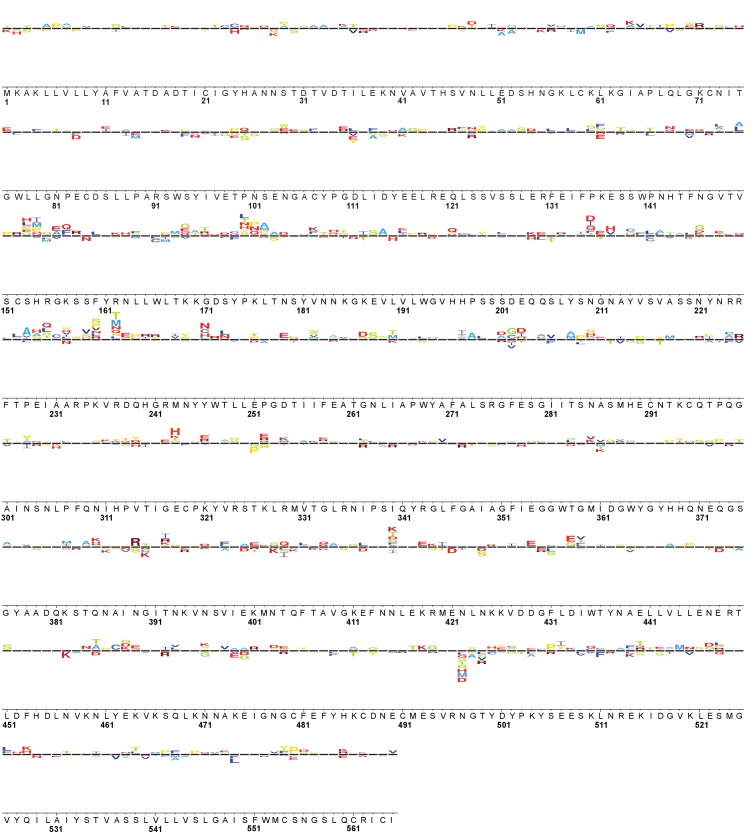
Full WSN HA sequence logo plot: ATF6f/XBP1s 37˚C vs. Basal 37˚C.Logo plot displays variants that behaved consistently across three biological replicates. Variants above the line (representative of selection on wild-type) were enriched upon ATF6f/XBP1s induction at 37˚C; variants below the line were depleted. The wild-type WSN HA residue is shown below the corresponding logo, with the sites numbered below the wild-type sequence (based on sequential numbering of WSN HA). The size of the amino acid letter abbreviation is proportional to the diffsel for that amino acid variant, and all logo plots are plotted on the same scale.